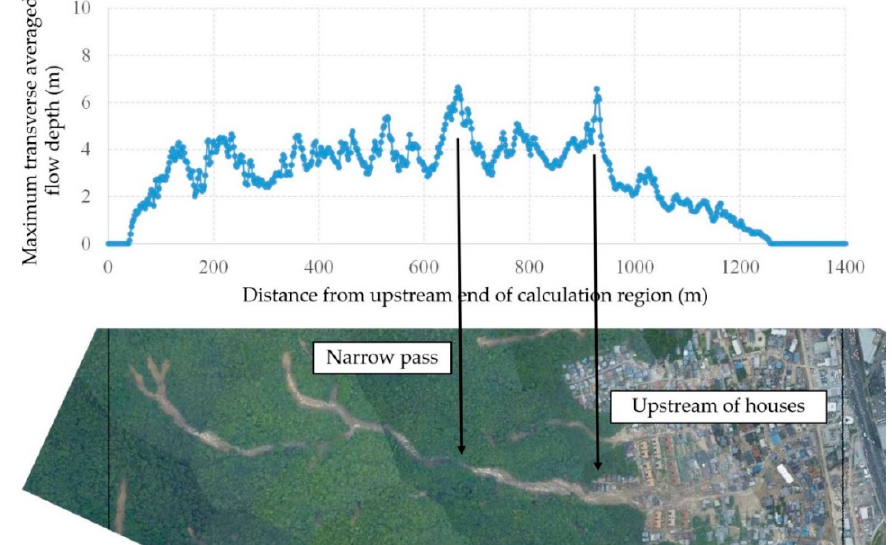
Figure 20. Longitudinal distribution of the deepest flow depth of each cross-section.